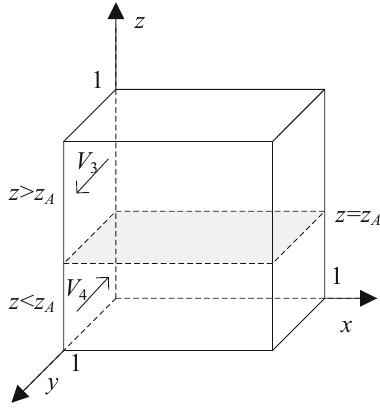
Fig. 3 Dynamic trend diagram for the freight shippers − r S services. when ( r N ) is increased and z C increases, CL CL and the area of V 2 expands. In other words, when the plat- form provides “low-level service”, freight carriers will tend to choose “do not share transportation capacity” to maxi- increases, r N decreases, and mize their profits. When r S CH CH z C decreases, the area of V 1 expands. This means that when the platform provides “high-level service”, the freight carri- ers will gain more profits by choosing “share transportation